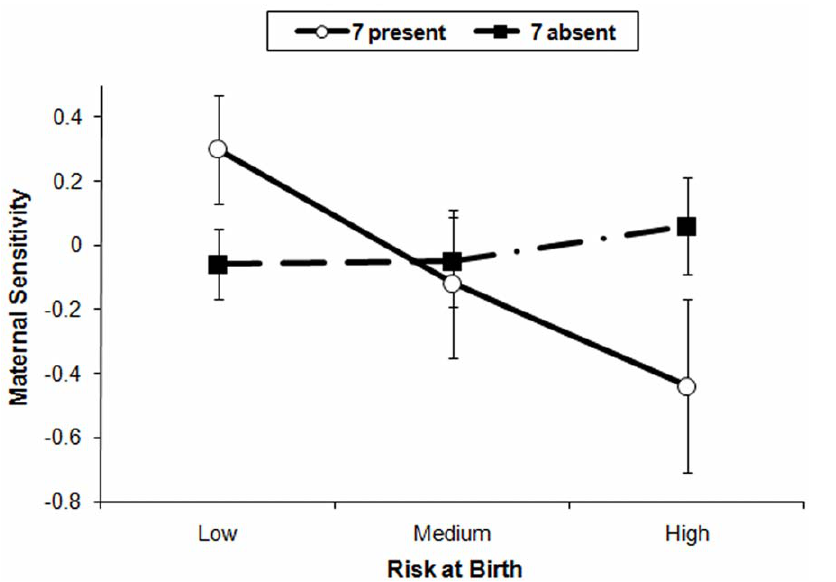
Figure 1. Mean maternal sensitivity based on risk at birth and the presence/absence of maternal DRD4-III 7-repeat allele. Mean levels (and standard errors) of observed maternal sensitivity as a function of child risk at birth (low, medium, and high) and the presence or absence of maternal DRD4-7R allele. Mothers who are non-carriers of the 7 allele showed no difference in levels of sensitivity under conditions of high, medium, and low risk at birth. Mothers who are carriers of the 7 allele were more sensitive to low-risk children and less sensitive to high-risk children.